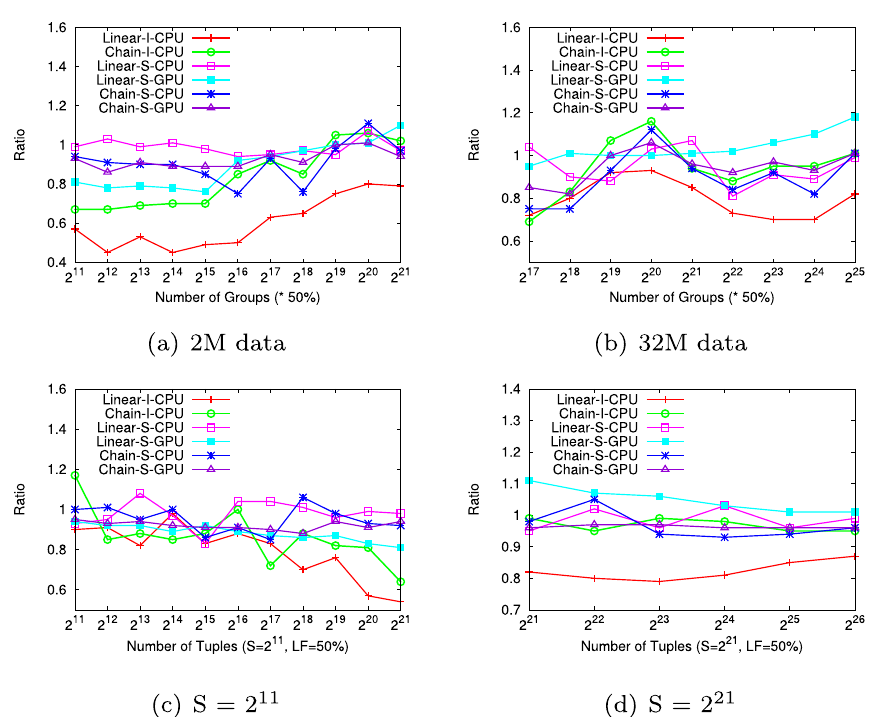
Fig. 11 Time ratios of various methods combined with Multiply-shift and Murmur hashing